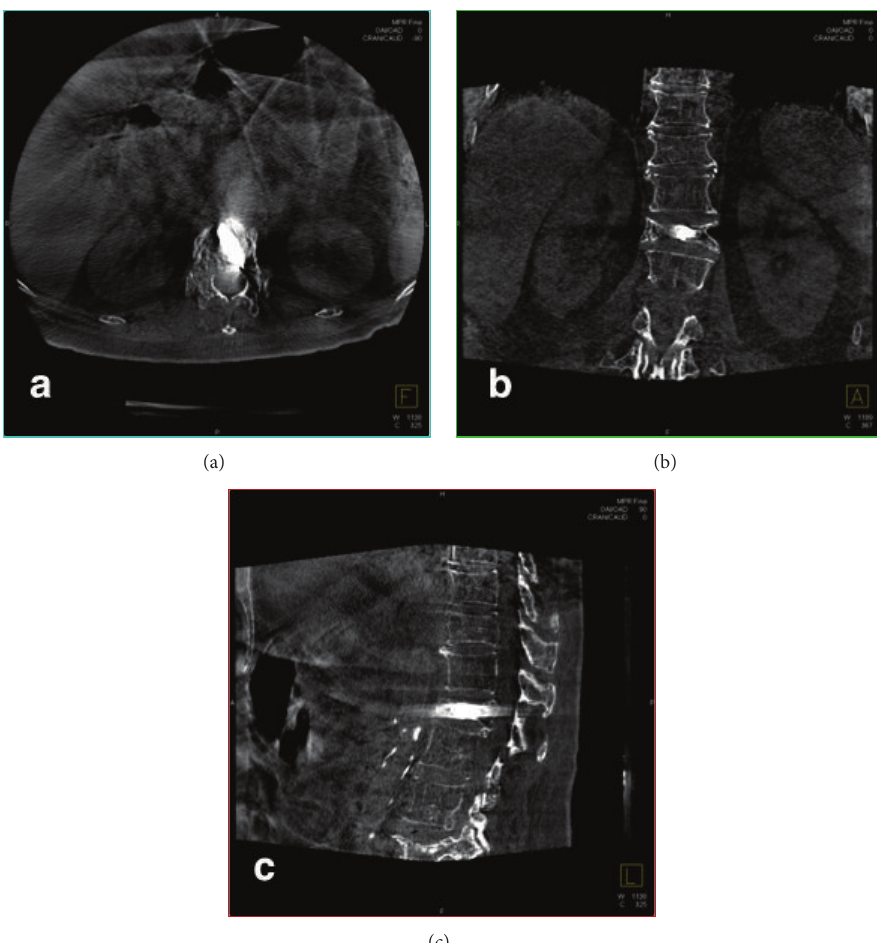
Figure 7: Flat panel detector-CT native images allow CT-like visualization of the disposal of intravertebral cement and its relation to neural foramina and the spinal canal ((a) and